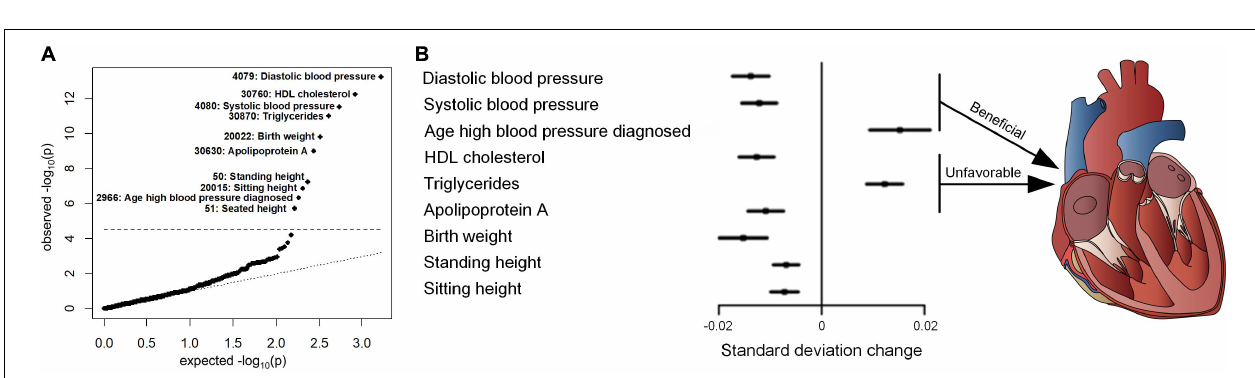
FIGURE 4 | PheWAS of rs1801253 in UKBB. (A) QQ plot. The black dashed line represents the Bonferroni-corrected threshold ( p = 0.05/1,646 = 3.04 × 10 - 5 ). The number indicates the field ID of variables in UKBB. (B) Forest plot of variables that were significantly associated with rs1801253. The estimates reflect the standard deviation change in the inverse ranked transformed variables per increase of rs1801253 G